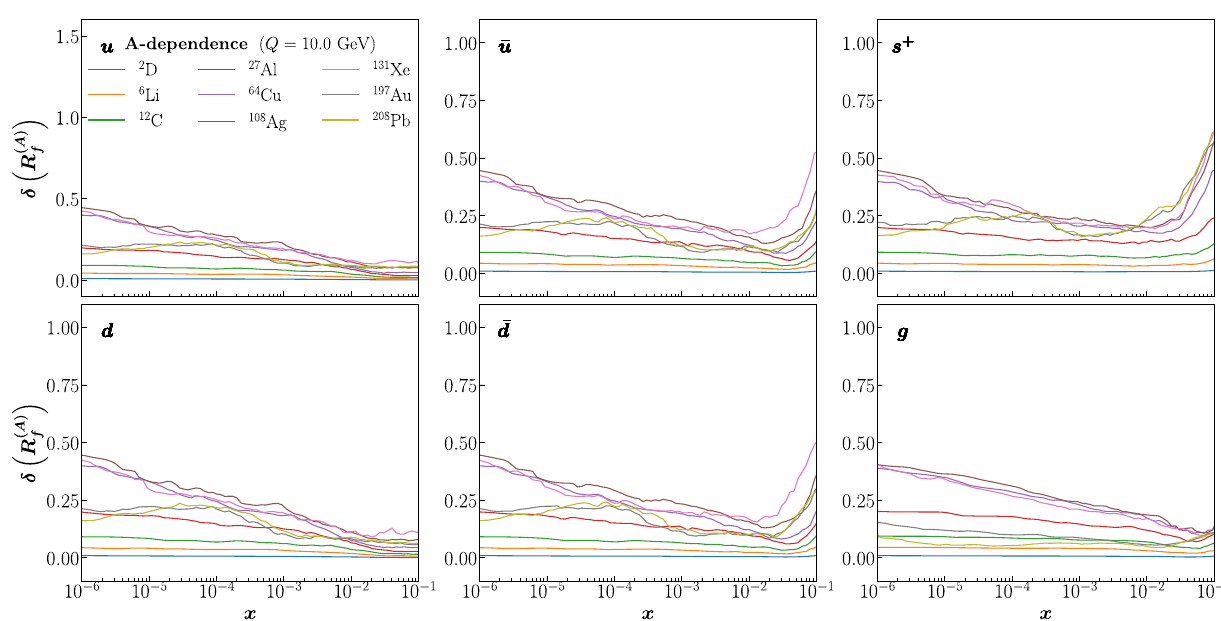
) , evaluated at Q = 10 GeV for the same nuclei as those f